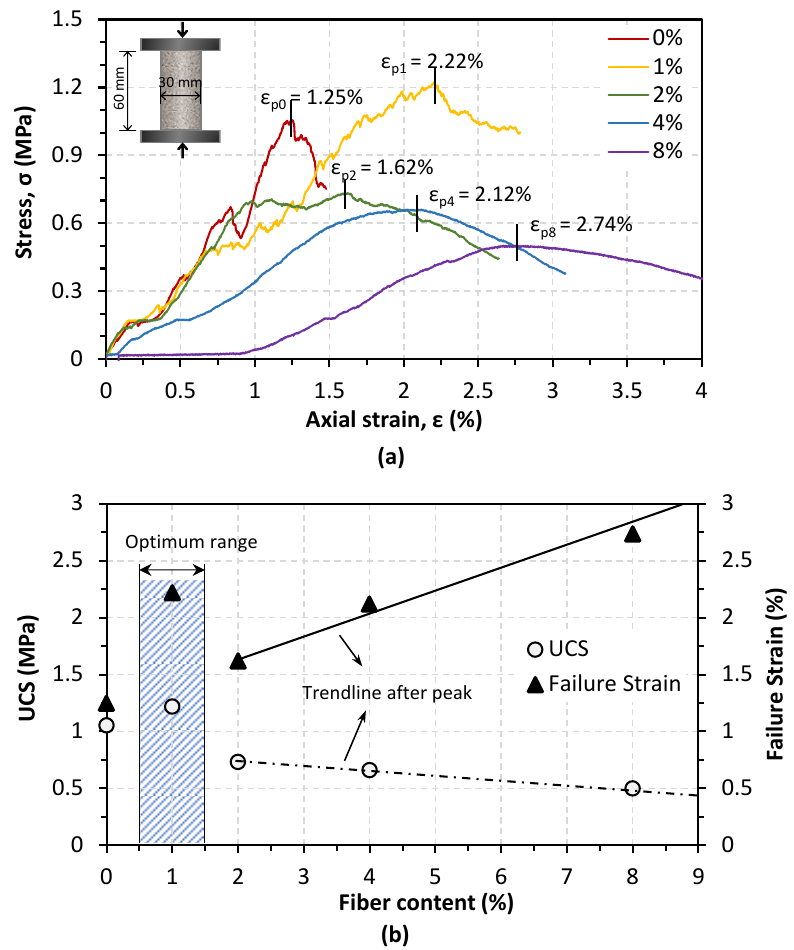
Figure 8. ( a ) Stress – strain behaviors of MICP-treated samples; ( b ) relationship between fiber content with UCS and failure strain.